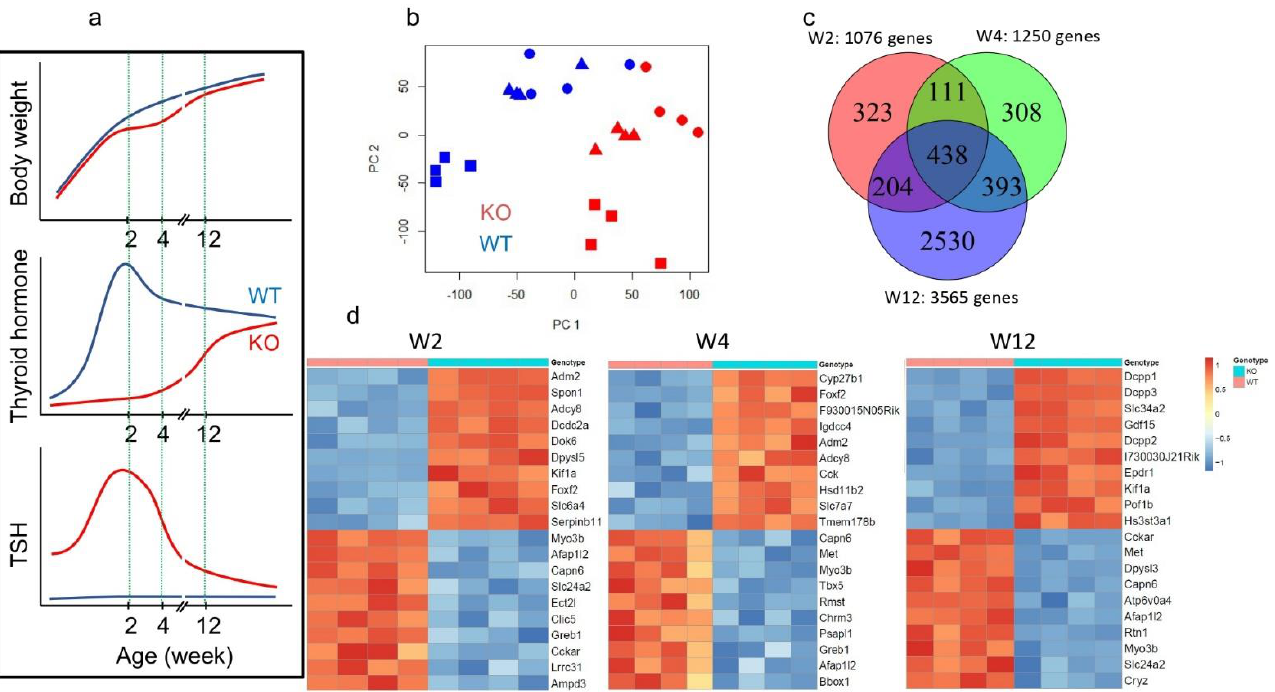
Figure 2. Differentially expressed genes in the thyroid glands between Xb130 +/+ and Xb130 − / − mice ( a ) Transient growth retardation of Xb130 − / − mice due to congenital hypothyroidism and experimental design. See original data in [11]; ( b ) Principal Component Analysis (PCA) of all genes from each microarray shows distinct differences in gene expression profiles between the thyroid glands of Xb130 +/+ and Xb130 − / − mice at each age point, with circles representing 2 weeks, triangles representing 4 weeks, and squares representing 12 months; ( c ) Venn diagram showing the overlap of differentially expressed genes (FDR < 0.05) among all 3 timepoints; ( d ) Heatmaps showing top 10 up- and down-regulated genes at each timepoint.